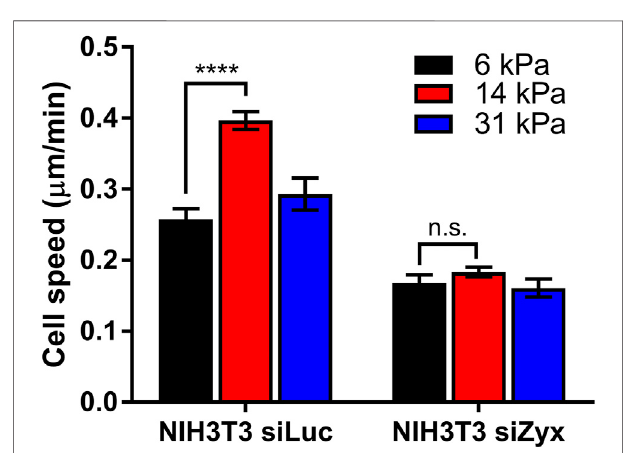
FIGURE4| GraphofcellspeedvssubstraterigidityforsiLuc-andsiZyx- NIH3T3 cells. n (cid:2) 62, 161, and 54 for siLuc-NIH3T3 6 kPa, 14 kPa, and 31 kPa, respectively. n (cid:2) 80, 81, and 85 for siZyx-, NIH3T3 6 kPa, 14 kPa, and 31 kPa respectively. Error bars represent standard error of the mean. **** represents p < 0.001 and n.s represents not signi fi cant.